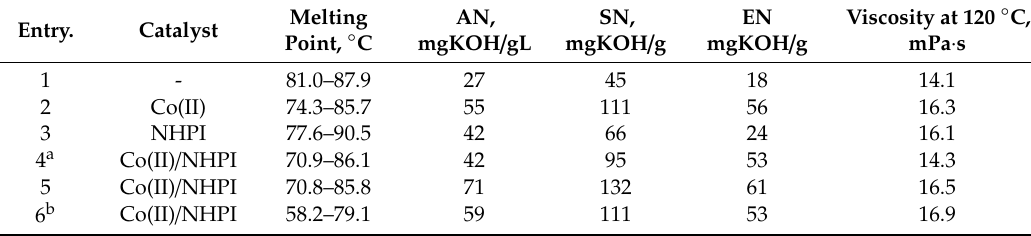
Table 6. E ff ect of catalyst on the oxidation of the pre-oxidized raw material using oxygen.